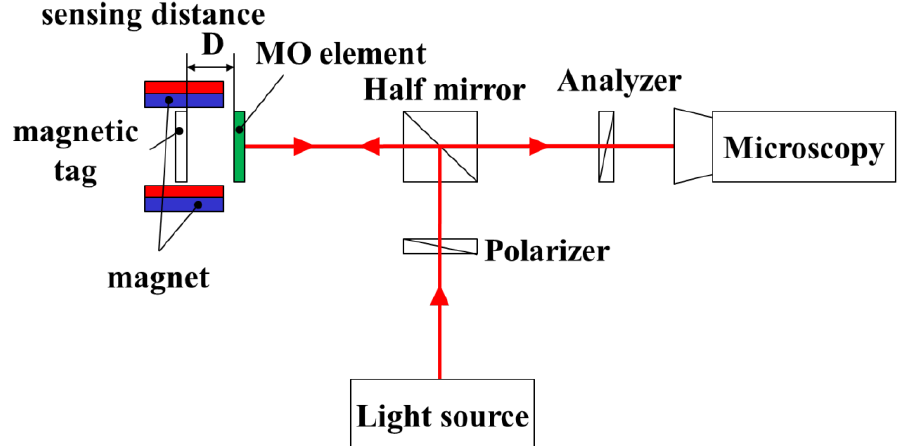
Figure 5. Experimental setup. After polarized light from the light source is rotated by the magneto-optical element, the analyzer cuts off the light according to its angle. Half mirror has a role of passing through half of the irradiated light and reflecting the rest. External magnetic field is controlled by changing the magnet arrangement around the tag.